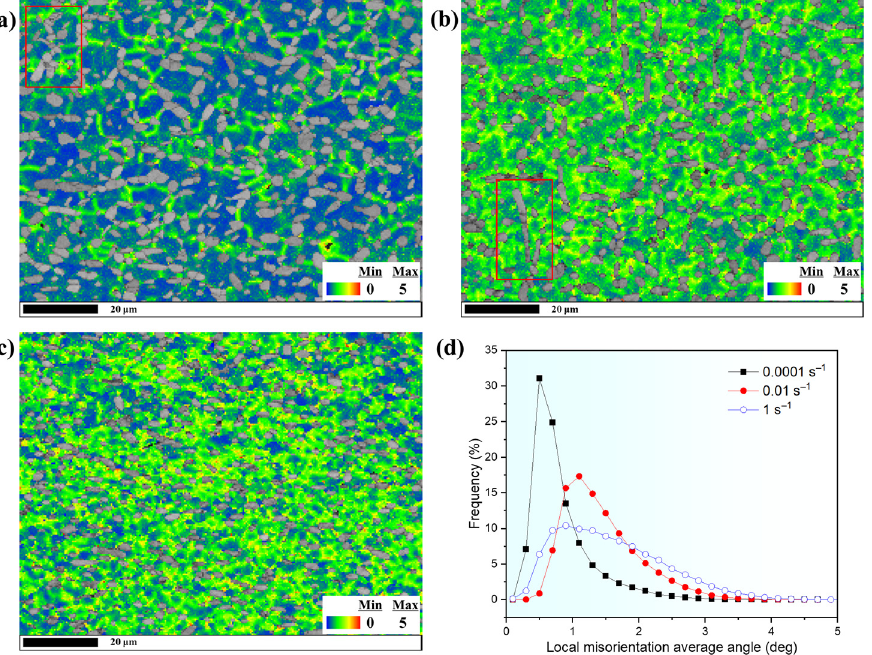
Figure 6. ( a – c ): the corresponding KAM maps of the β phase in Figure 3d–f; ( d ) the local misorientation distribution map.